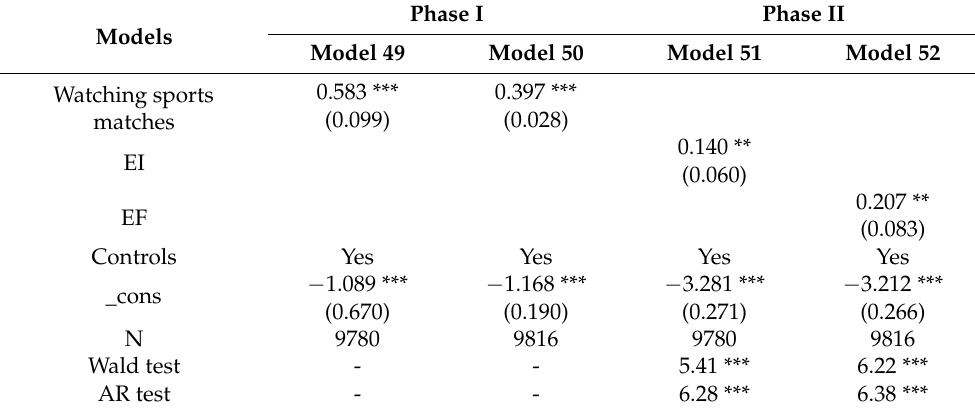
Table 10. Instrumental variable